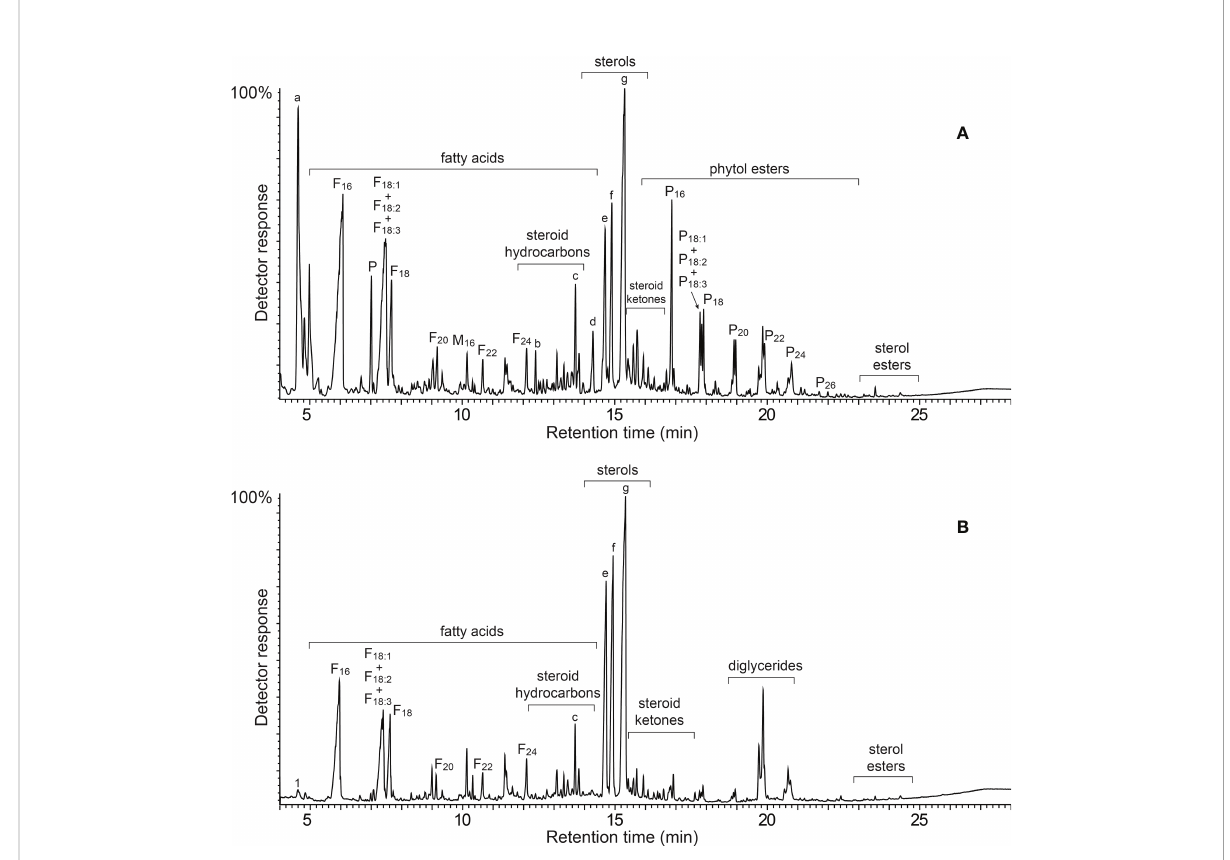
FIGURE 1 GC-MS chromatograms of the underivatized lipid extracts from (A) the rind, and (B) the pith of papyrus stems. F(n), n -fatty acid series; M(n), monoglycerides; P, phytol; P(n), phytol esters series. Labels for selected compounds are: a, phytadiene; b, squalene; c, stigmasta-3,5,22-triene; d, a -tocopherol; e, campesterol; f, stigmasterol; g,